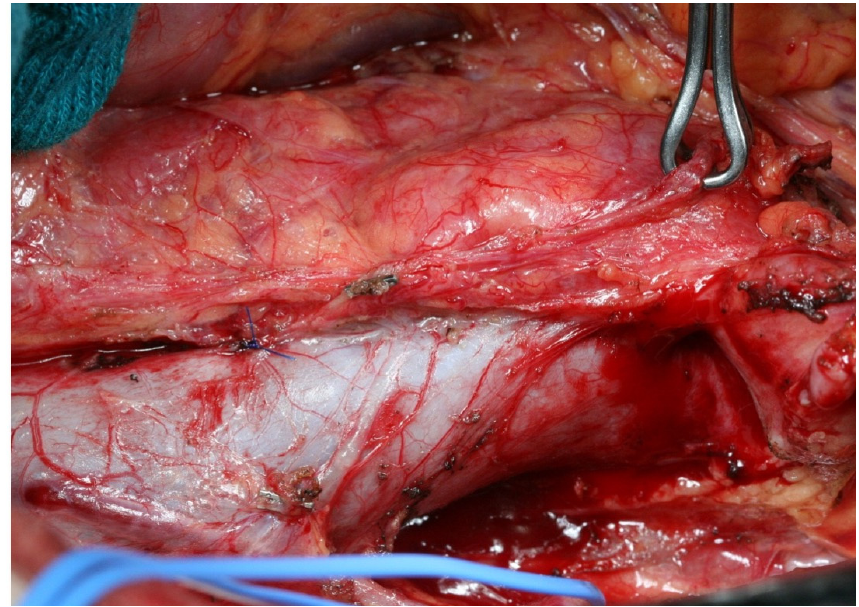
Figure 4. Bulky nodes in 16a2-b1 stations.